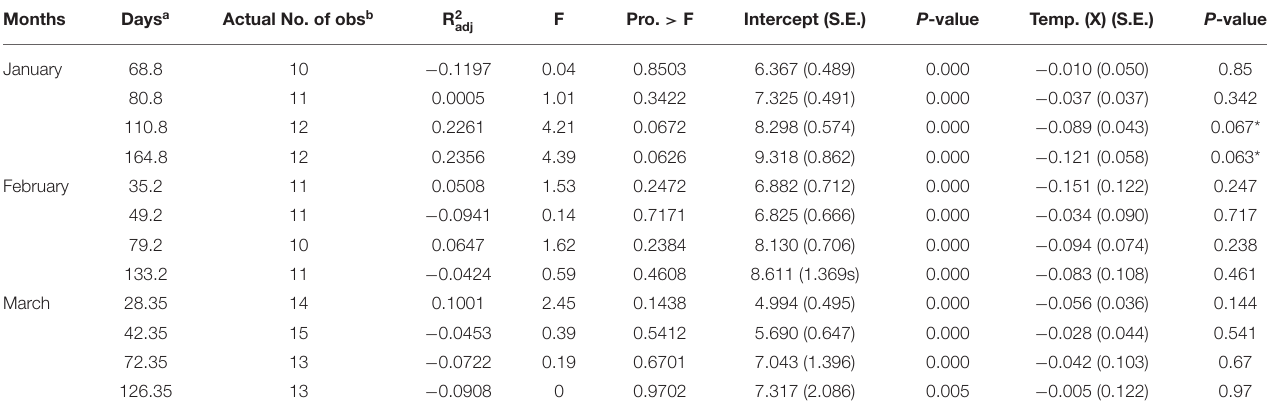
TABLE 1 | Results of the regression models.